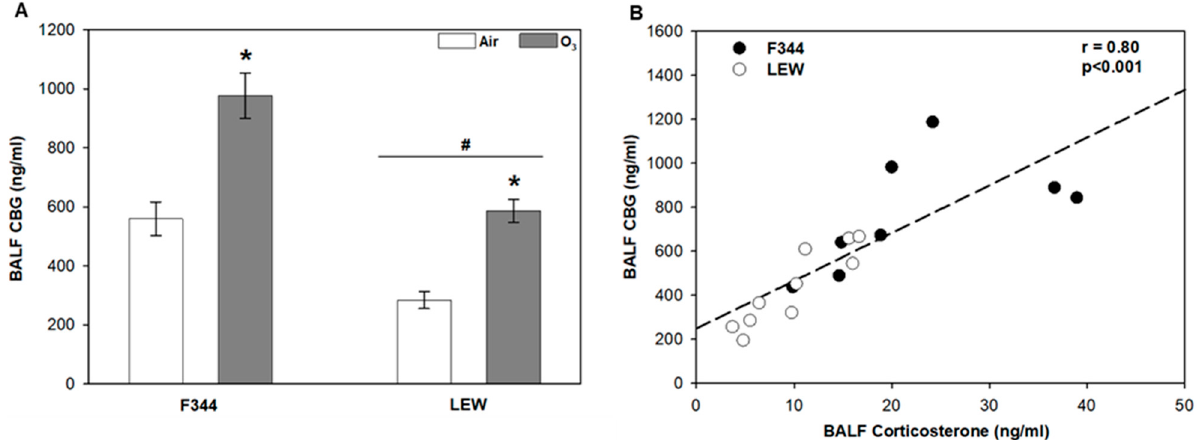
Figure 1. Strain comparison of lung lavage corticosteroid-binding globulin (CBG) after ozone inhalation. A. CBG levels in bronchoalveolar lavage fluid (BALF) in Fischer (F344) and Lewis (LEW) exposed to air or 0.8 ppm ozone (O 3 ) for 4 h. * Ozone main effect, p < 0.001; # Strain main effect, p < 0.001; two-way analysis of variance (ANOVA) with Holm–Sidak post-hoc test; n = 4–5 rats/strain/treatment. Data are expressed as mean ± SEM. B. Relationship between BALF corticosterone and CBG in F344 and LEW (Pearson correlation).